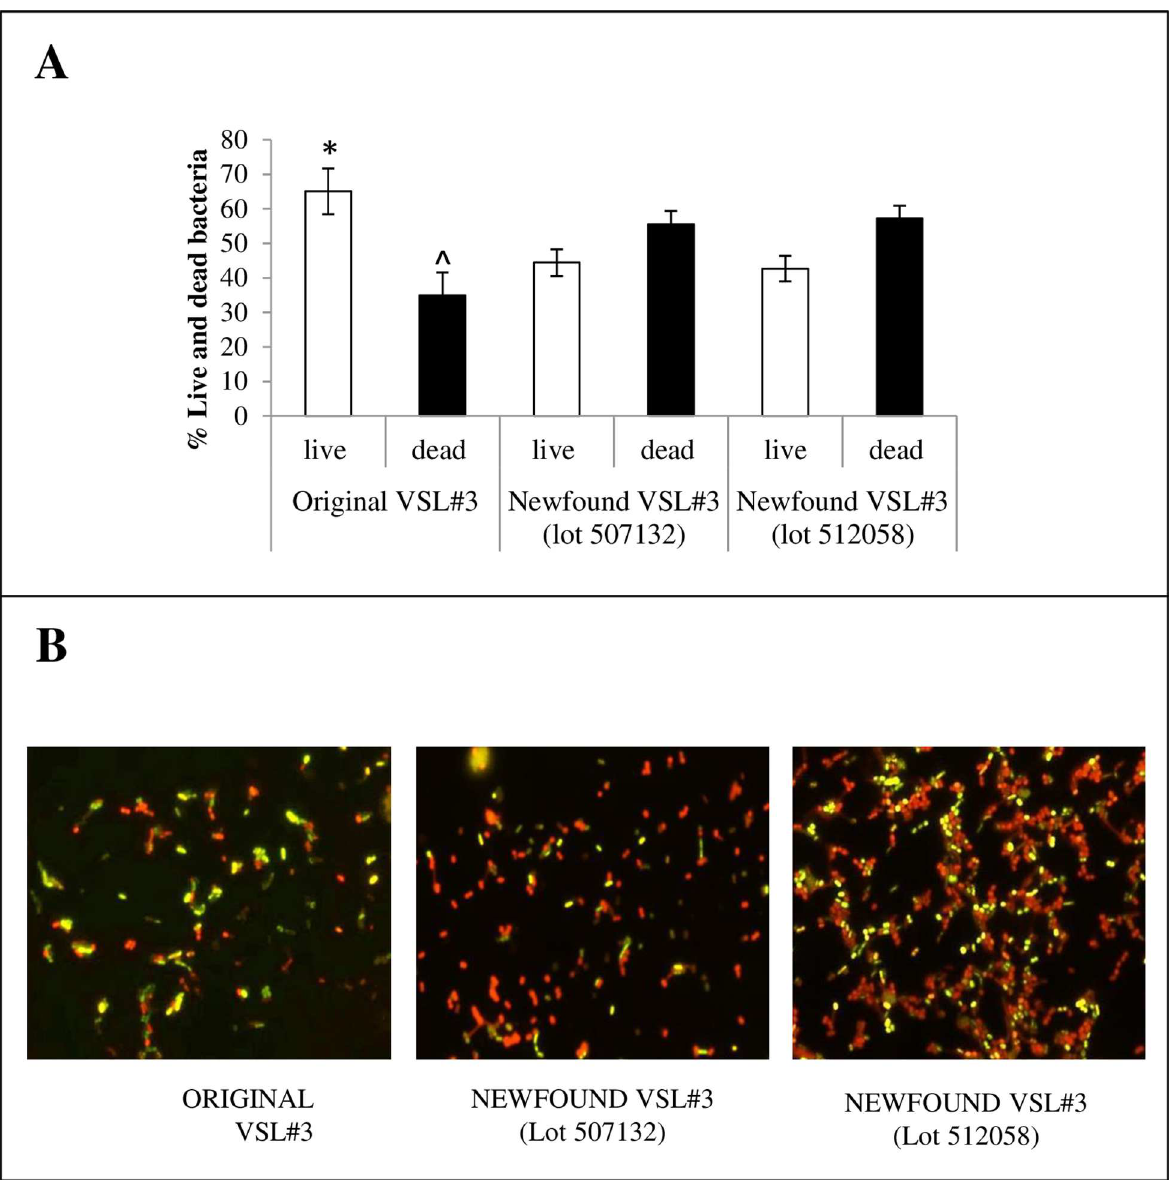
Fig 2. Live vs dead bacteria in “original” and “newfound” VSL#3 product. Panel A: The percentagesof live and dead cells in each VSL#3 formulations presented as mean ± SD of n. 10 determinations are shown. (Live cells * P < 0.001 vs both lots of newfound formulations; Dead cells ^ P < 0.001 vs both lots of newfoundformulations). Panel B: Representative microscopy images of bacteria stained with SYTO 1 13 and Propidium Iodide are shown. Stained bacterial suspensions were analyzedusing a fluorescent microscope. Red colour is due to SYTO 1 13 green fluorescencethat was quenchedby that of PI (dead bacterial cells), while bright green-yellow colour was due to SYTO 1 13 staining when PI did not permeate across the cell membrane (live bacterial cells). Magnification100x.